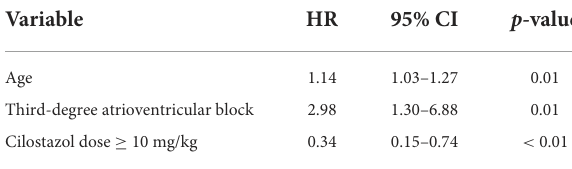
TABLE 7 Hazard ratio for reaching secondary endpoint by multivariate Cox proportional hazards